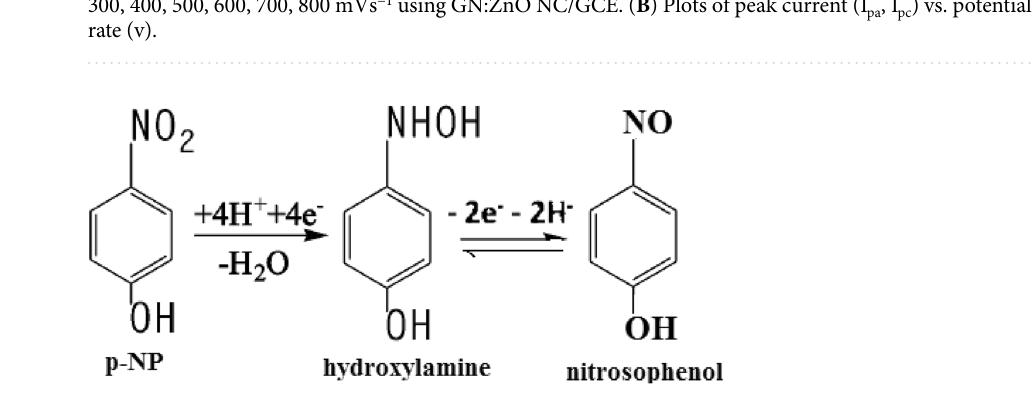
Scheme 2. Electrode reaction mechanism of p-nitrophenol at GN:ZnO